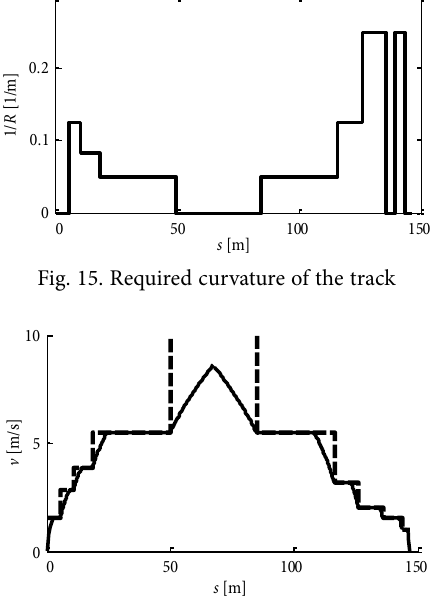
Fig. 14. Chart of the centerline of the track